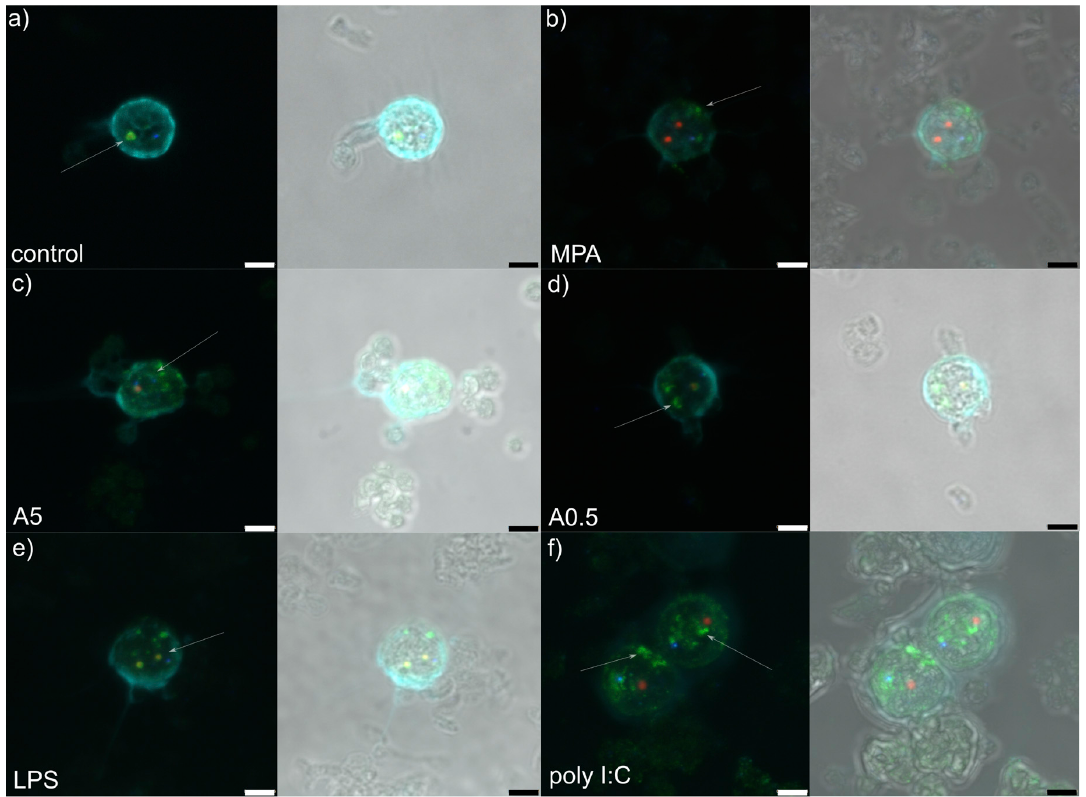
Figure 2. Z-stack representative microphotograph of immunocytochemical localization of Cajal bodies (coilin, in blue), granular components (B23 / NPM1, in green), dense fibrillar components (Nop58; in red) and cell nucleus (pale blue, labelled by 4,6-diamidino-2-phenylindole [DAPI]) in rat peripheral blood mononuclear cells 12 h post-stimulation with: ( a ) RPMI-1640 medium (control); ( b ) mycophenolic acid (MPA; immunosuppressor); ( c ) 5 µ g of A. pegre ffi i crude extract; ( d ) 0.5 µ g of A. pegre ffi i crude extract; ( e ) bacterial lipopolysaccharide (LPS); ( f ) polyinosinic:polycytidylic acid (poly I:C; viral analogue). Signals are also viewed overlaid in a bright field microphotograph. White arrows point to the appearance of the granular components. Scale bars: 3 µ